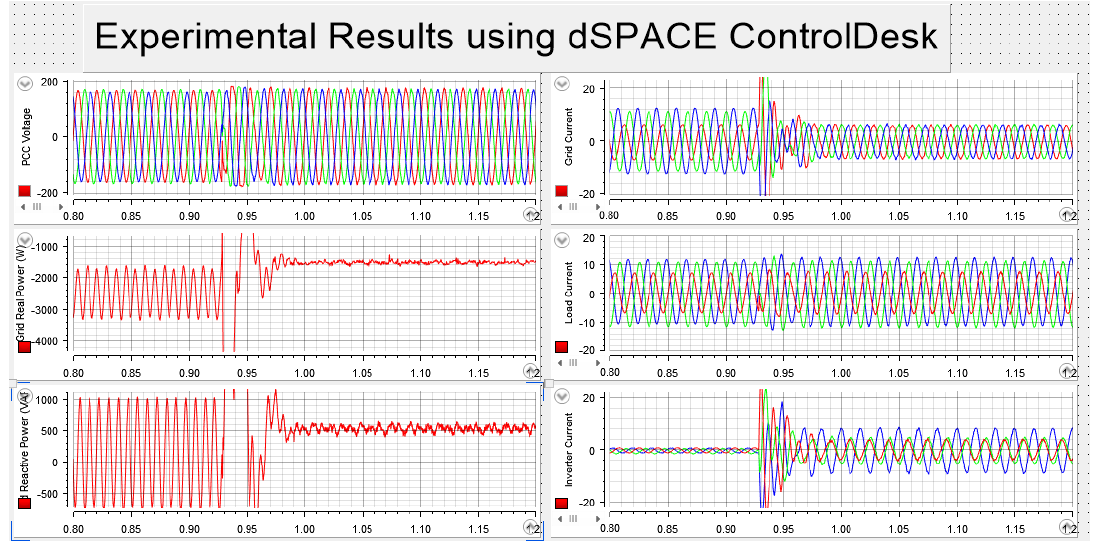
Figure 29. Hardware results using dSPACE Controldesk for real power = − 1.5 kW and reactive power = 0.5 kvar under unbalanced grid inductances.